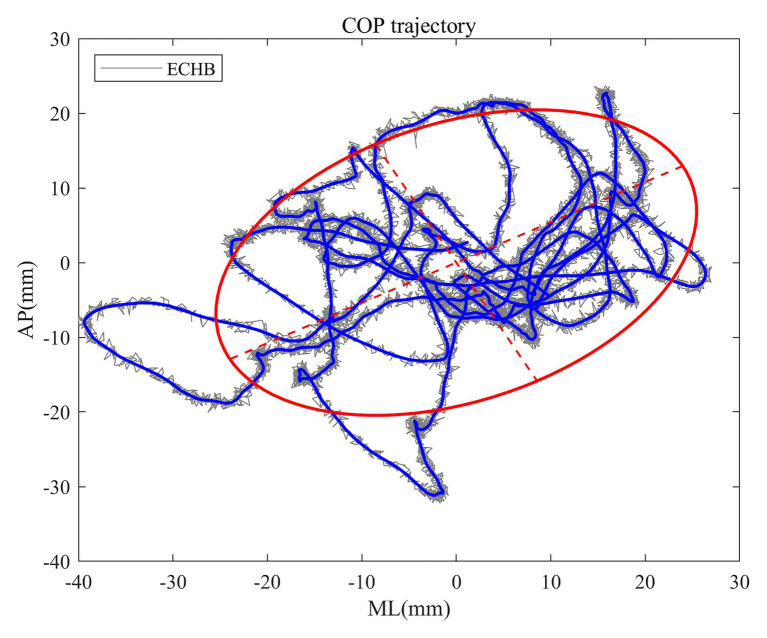
The raw (gray trace) and filtered (blue trace) center of pressure (COP) signals for a 4-year-old child under the condition of eyes closed and head extended backward (ECHB) during 15 s. Estimated sway area (red trace) is superimposed onto the plots of COP trajectory.